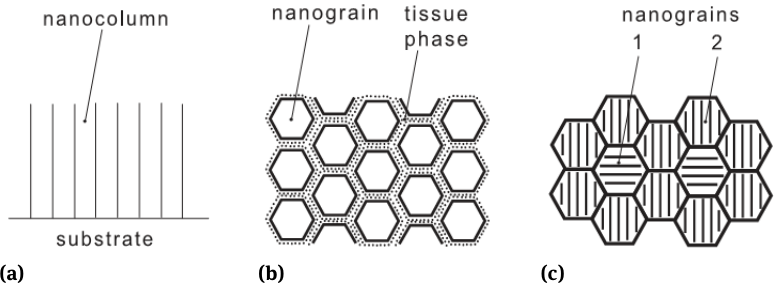
Figure 2: Schematic diagram for nanocomposite coatings with enhanced hardness (a) Columnar structure (b) Nanograins surrounded by tissue phase (c) mixture of Nanograins with different orientation